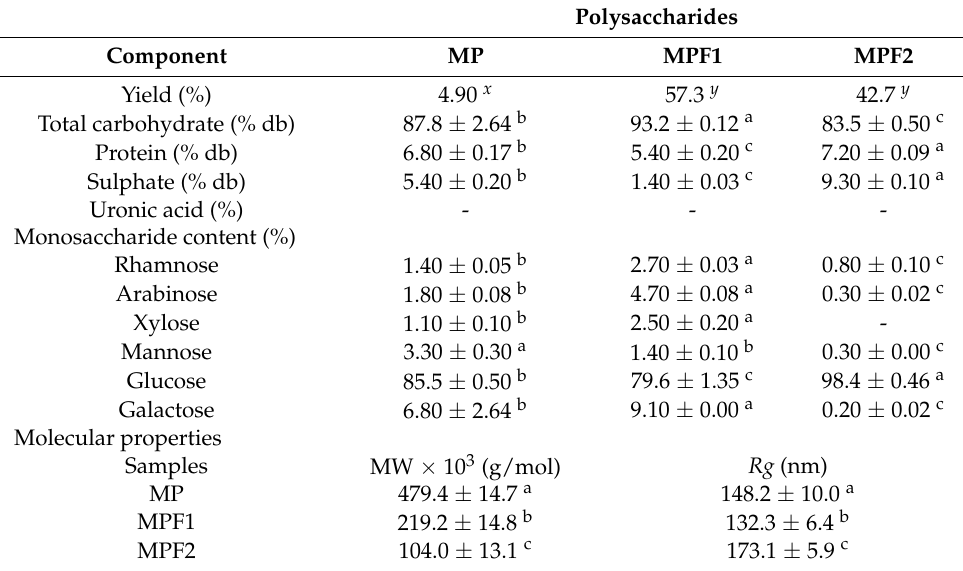
Table 2. Extraction methods, characterisation, and bioactivities of polysaccharide from edible mush- room of A. hemibapha subspecies javanica